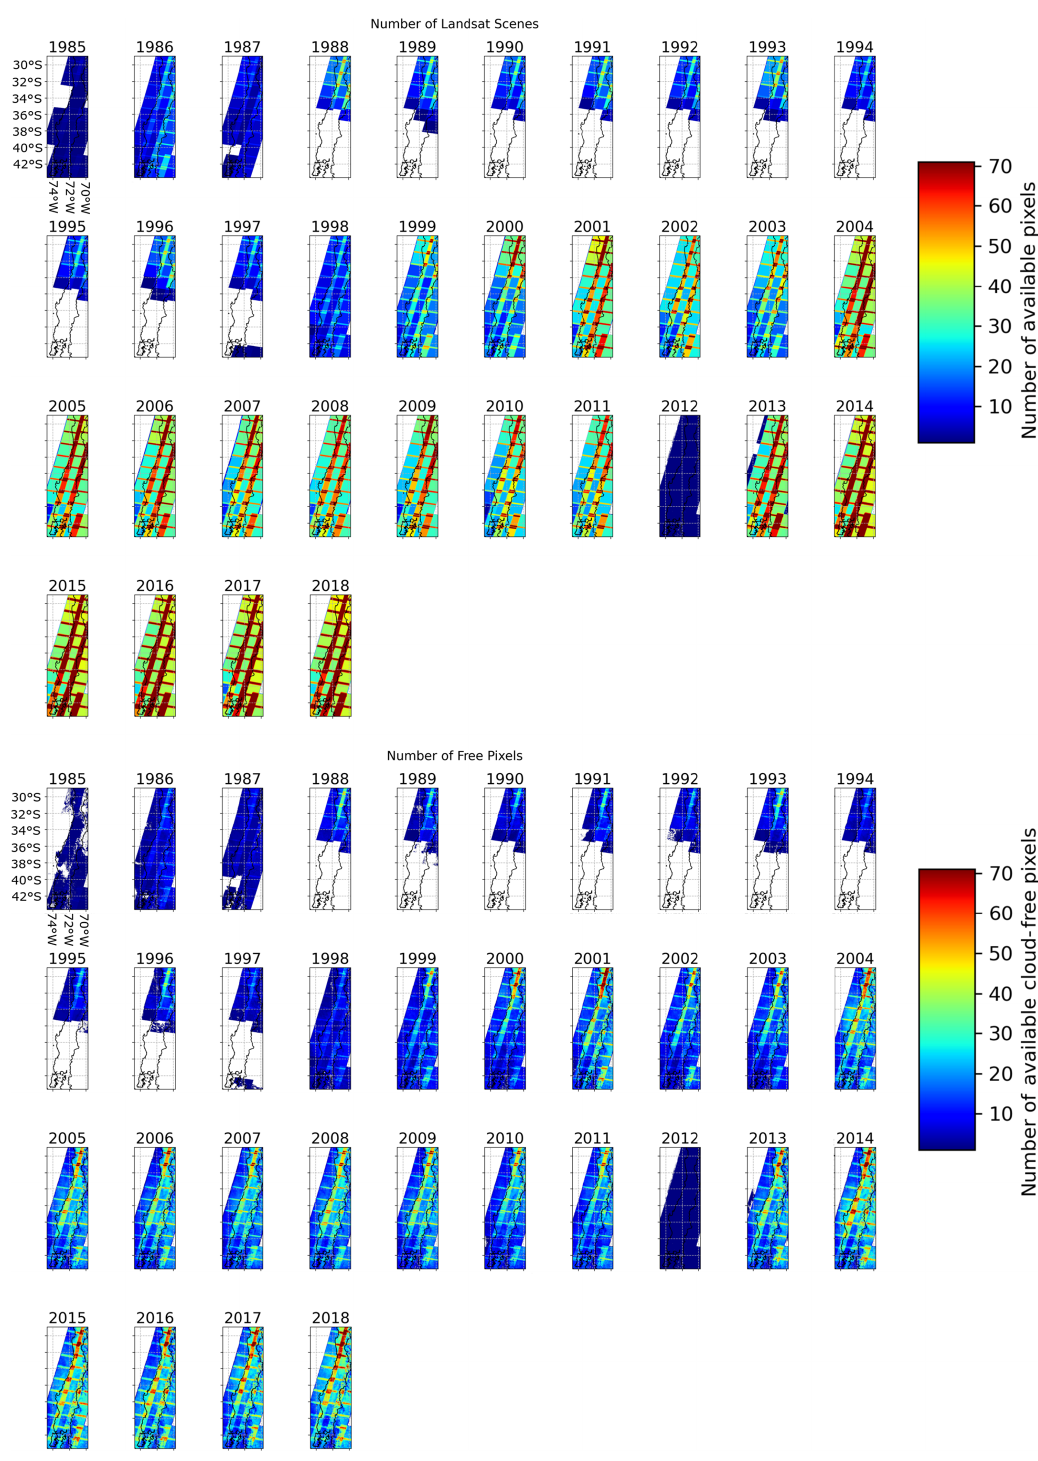
Figure 5. The upper set of panels shows the available Landsat pixels over study area for each respective year from 1985 to 2018. The lower set of panels represents the number of available cloud-free Landsat pixels per year for the same respective